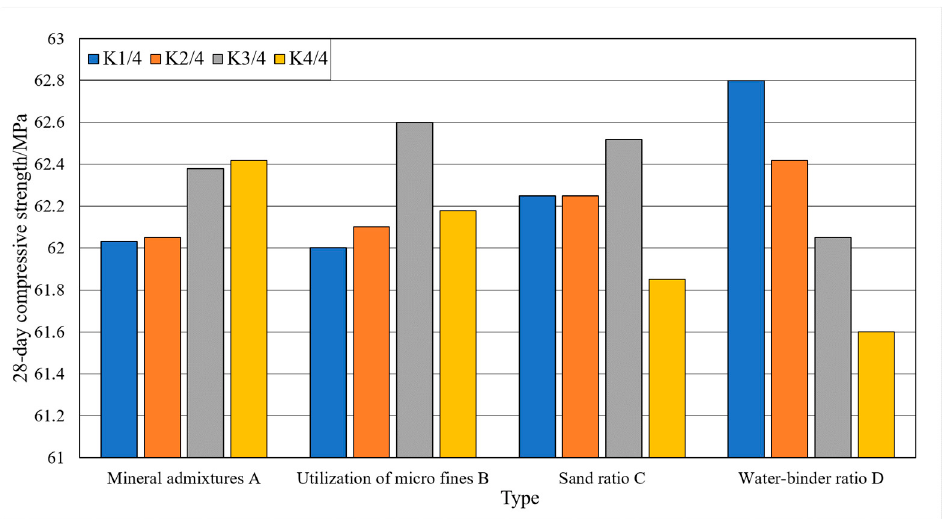
Figure 7. Trend of the influence of factors on the results of 28-day compressive strength test.